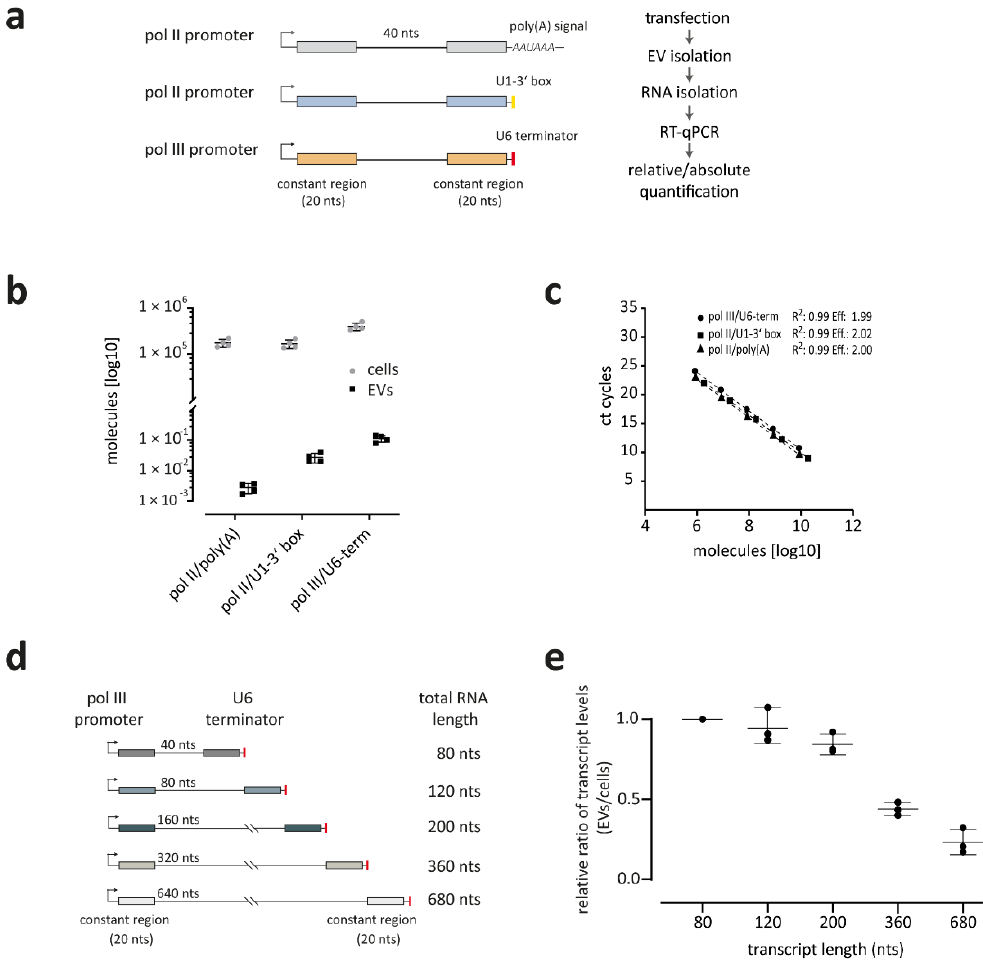
Figure 2. RNA polymerase expression platforms affect RNA packaging into extracellular vesicles. ( a ) Design of expression constructs: pol II/poly(A), pol II/U1-3 ′ box, and pol III/U6-term. After co-transfection of all three constructs, total RNA was isolated from HEK293 cells and purified EVs, followed by RT-PCR, using primers directed against the respective constant regions. ( b , c ) Expression-dependent efficiency of RNA packaging into EVs, quantified by RT-qPCR in absolute copy numbers (molecules per cell and per EV; in log10; panel. For the determination of absolute values, four datasets were used ( n = 4), indicating mean and standard deviations (for standard curve with equations and amplification efficiencies, see panel c ). ( d , e ) Size-dependent packaging of RNAs into extracellular vesicles. Design of expression constructs. All constructs harbor an RNA pol III (U6) promotor, followed by a randomly generated sequence with different sizes (40, 80, 160, 320, 640 nts), flanked by two unique constant regions (20 nts). All constructs contain a U6 termination signal (red), resulting in an RNA with a γ -monomethyl cap and no poly(A) tail (panel d ). Length-dependent efficiency of RNA packaging into EVs, quantified by RT-qPCR as a relative ratio between EV-associated and total cellular RNA (EV/cells). Constructs were transfected in HEK293 cells, followed by total RNA isolation from cells and purified EVs. RT-qPCR was performed and the relative packaging of the individual transcripts (80, 120, 200, 360, 680 nts) into extracellular vesicles was analyzed ( n = 3), normalized total expression in cells (panel e ).